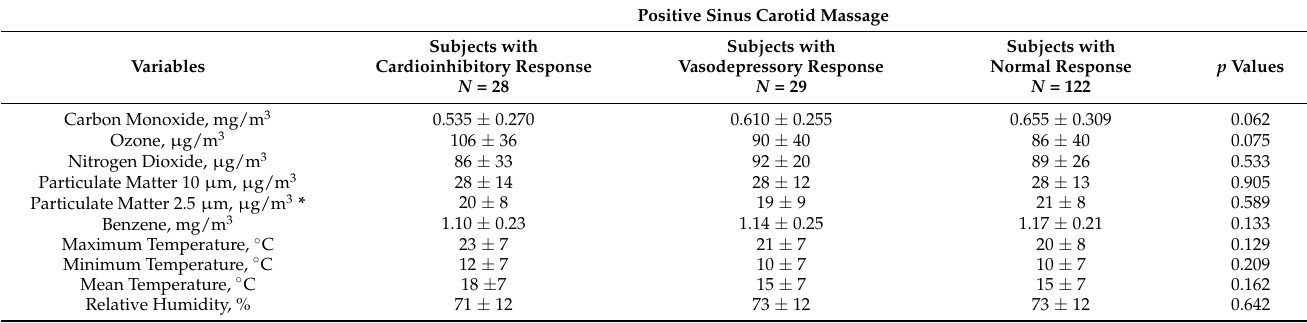
Table 2. Air Pollutants and Weather Data on the Day of the Cardiovascular Test. Positive Sinus Carotid Massage